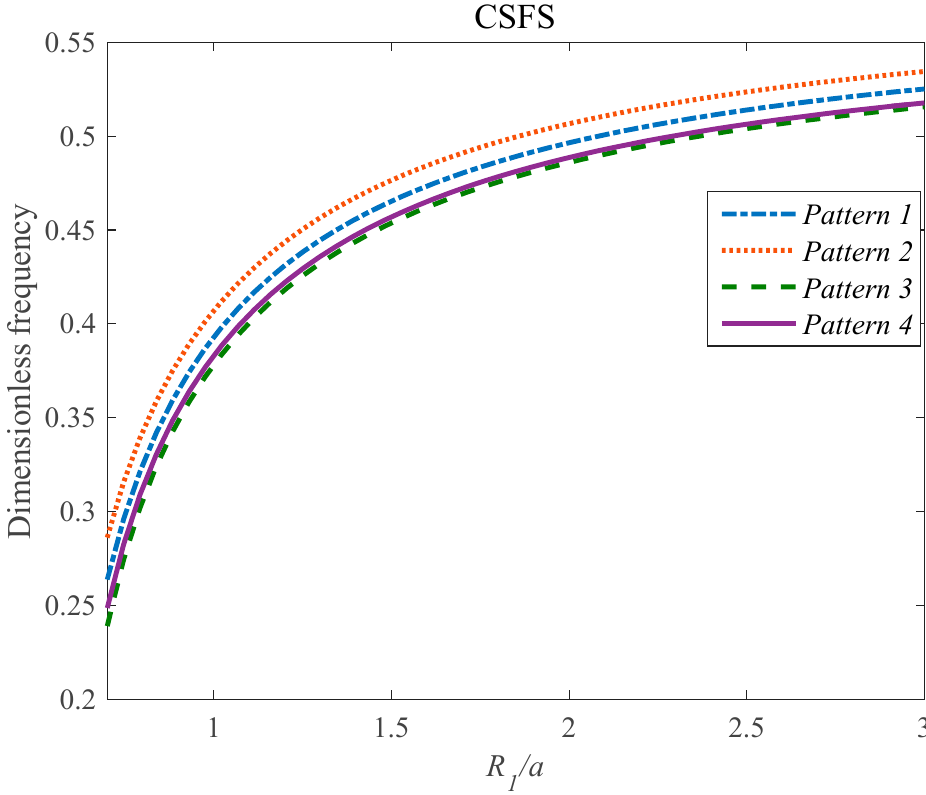
Figure 8. The e ff ects of R 1 / a and GPLRC’s pattern on the frequency for the CFSF boundary conditions Figure 8 . The effects of R 1 /a and GPLRC’s pattern on the frequency for the CFSF boundary conditions (a/b = 5, (a / b = 5, h = b / 10, R2 = 5a, ∆ T = 100 K , g GPL = 0.5%, N L = 10, µ = h /10, l = h h = b/10, R2 = 5a, ∆𝑇 (cid:3404) 100𝐾, 𝑔 (cid:3008)(cid:3017)(cid:3013) = 0.5%, N L = 10, 𝜇 (cid:3404) ℎ/10, 𝑙 (cid:3404) ℎ/5 ).